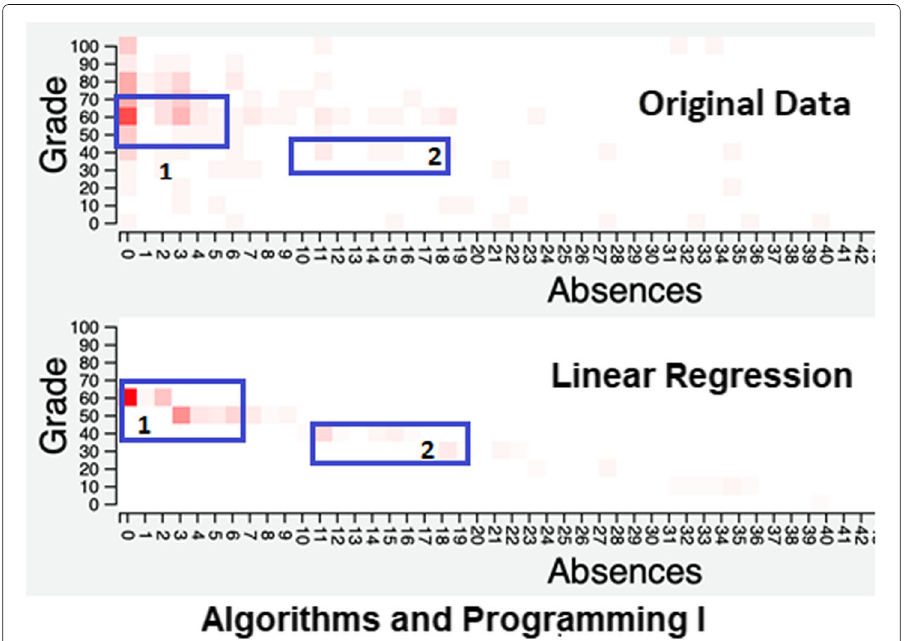
Fig. 13 Algorithms and Programming I: Original data vs. SVR linear